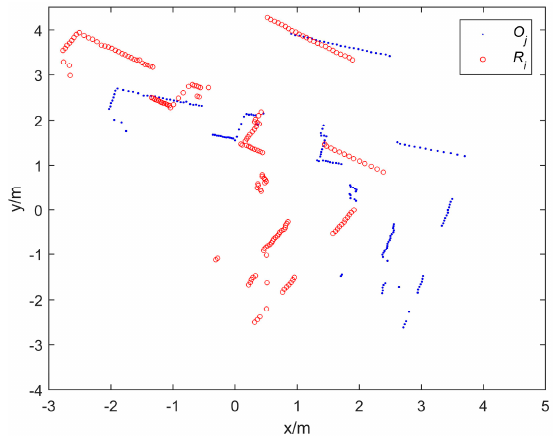
Figure 4. Laser data points.